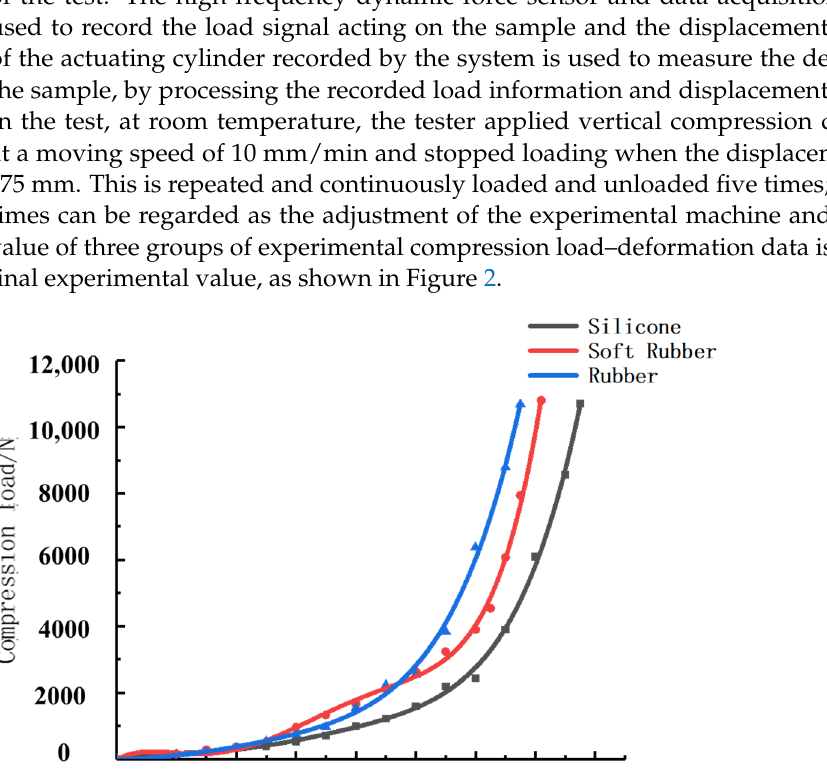
Figure 1. Uniaxial compression test: ( a ) before compression; ( b ) after Compression.